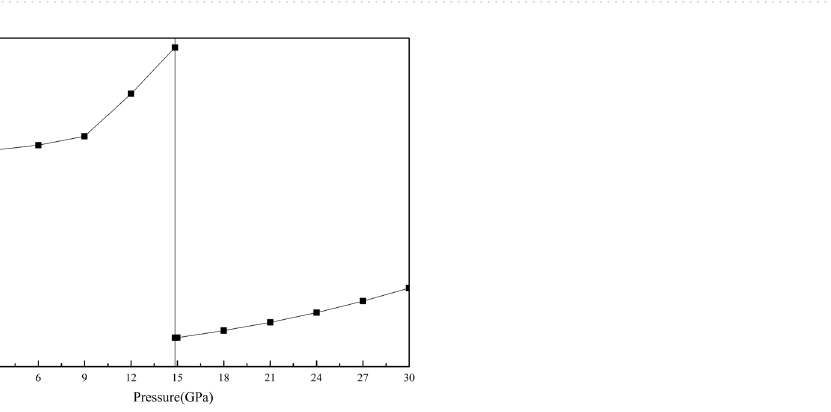
Figure 4. The B/G ratio as a function of pressure for both B3 and B1 phases of ZnSe.